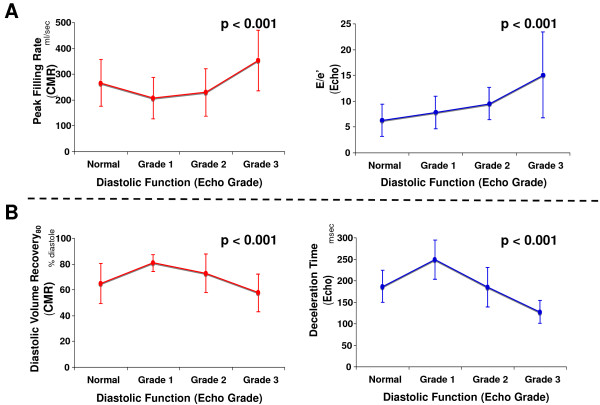
Diastolic Filling Indices in Relation to Severity of Diastolic Dysfunction. Diastolic indices by cine-CMR (red) and echo (blue) stratified by echo-assigned diastolic grade. (A) PFR by cine-CMR paralleled E/e' by echo. (B) DVR80 by cine-CMR paralleled echo-evidenced deceleration time (data presented as mean ± SD).